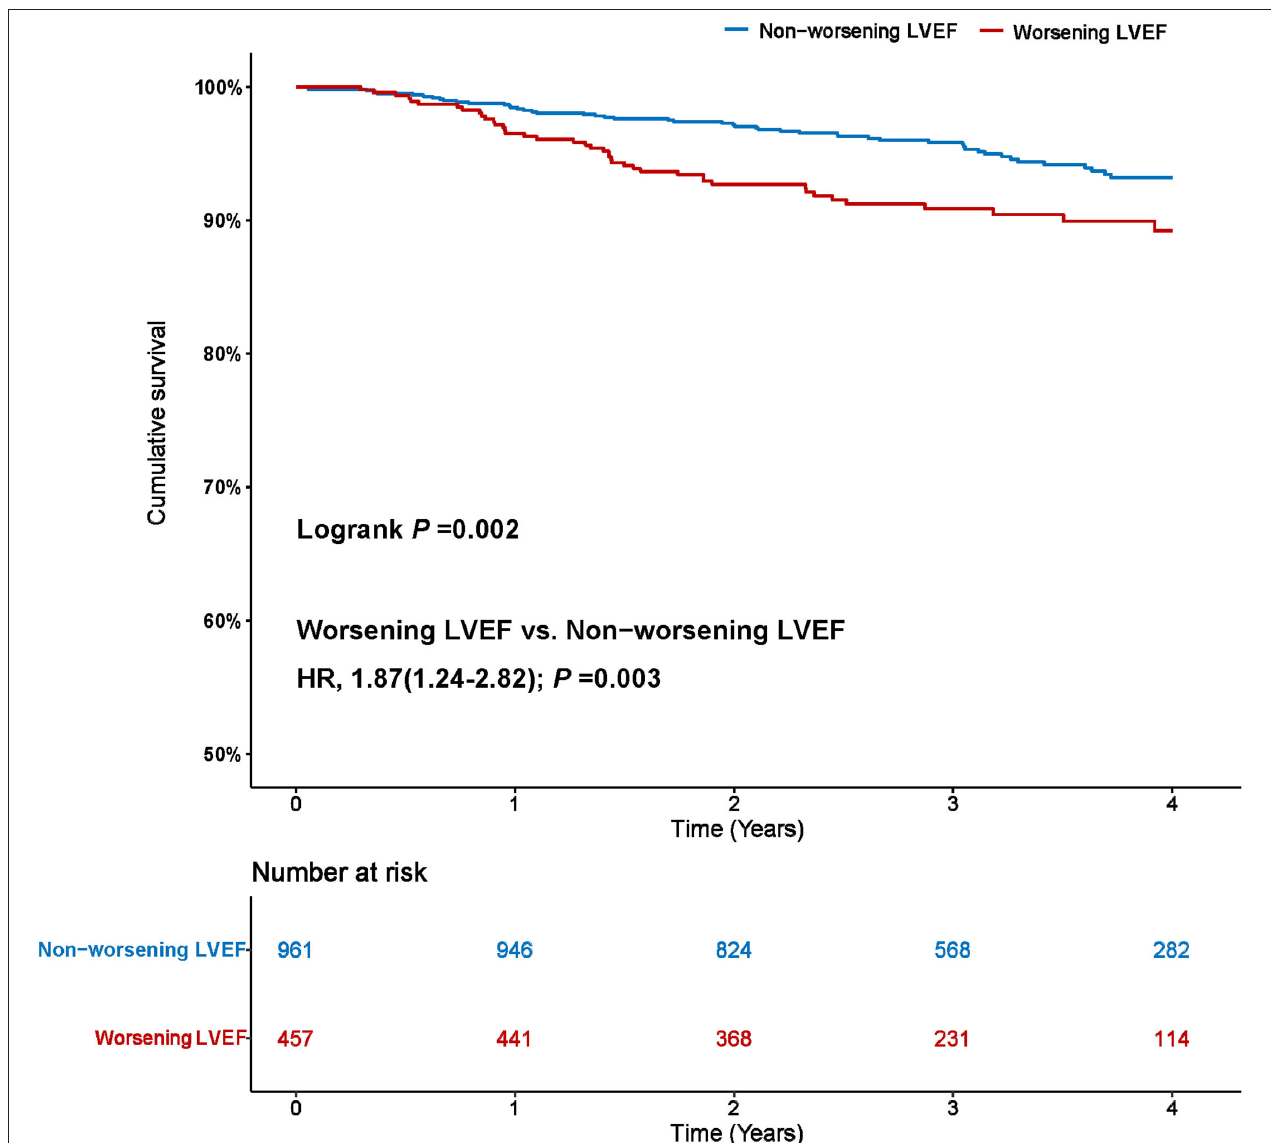
FIGURE 2 | Worsening left ventricular ejection fraction (LVEF) and risk of mortality. The Kaplan–Meier curves for all-cause mortality in patients with heart failure with preserved ejection fraction (HFpEF) with and without worsening